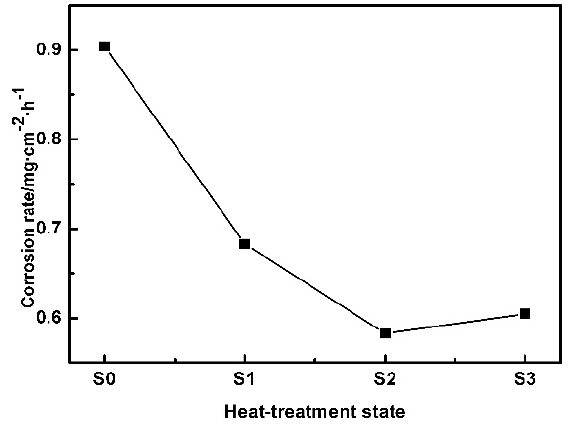
Figure 6. Corrosion rates of the TZA 442 alloy in different states by immersion test. Table 1. Corrosion potential ( E corr ) and the corrosion current density ( I corr ) for TZA442 alloy in different heat-treatment states.